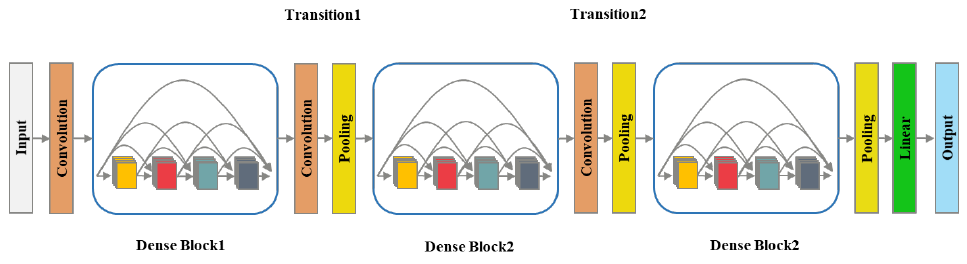
Figure 5. The structure of DenseNet with three dense blocks and two